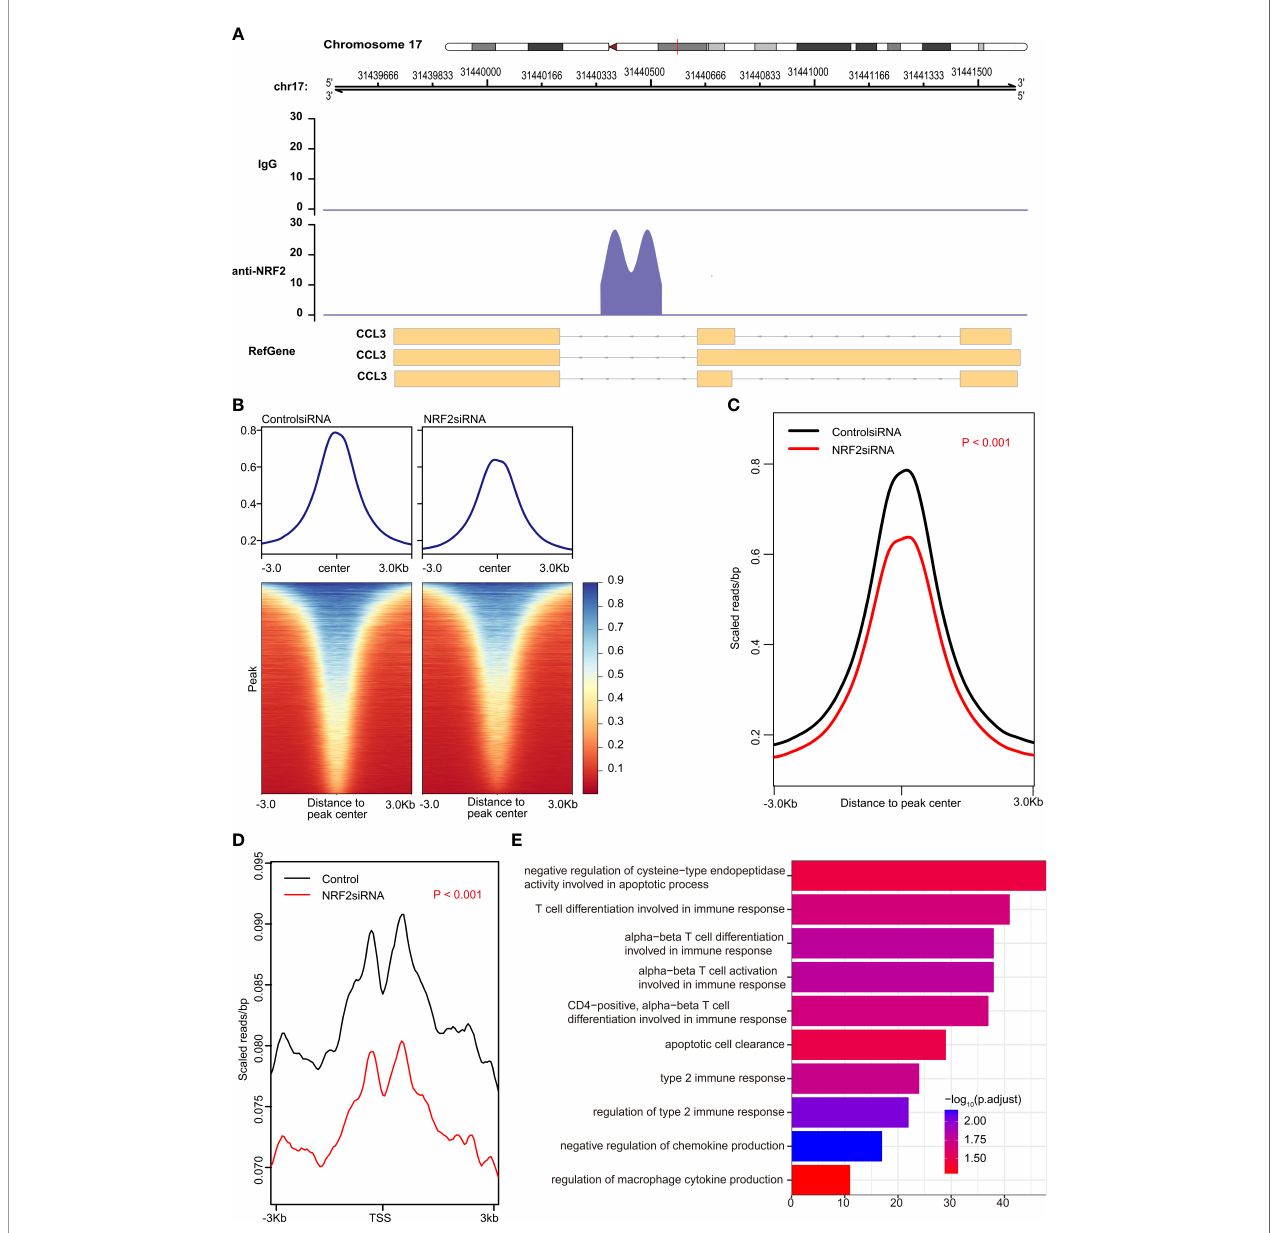
FIGURE 4 | Nrf2 promoted transcription of Ccl3 validated by chromatin immunoprecipitation sequencing (CHIP-seq). (A) anti-NRF2 antibodies could bind to the DNA fragments of Ccl3, rather than to Ccl2 or Ccl7. (B) Heatmap of the peak signal. (C) The peak signal was signi fi cantly reduced in the NRF2 silencing group compared with the control group (P < 0.001). (D) The transcription start site (TSS) signal was signi fi cantly reduced in NRF2 silencing group, as compared with the control group (P < 0.001). (E) Gene Ontology (GO) analysis of peak